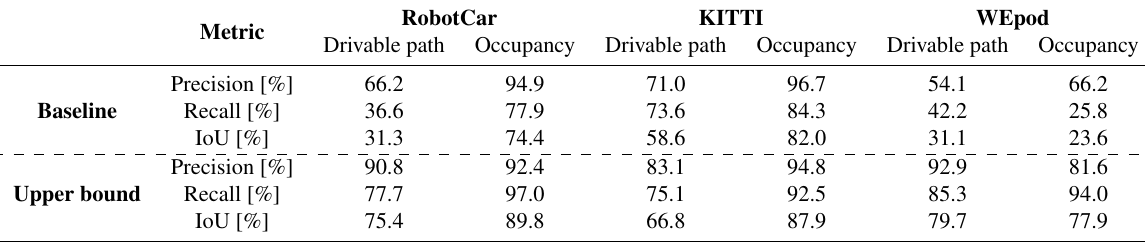
Table 1: Evaluation values for the baseline and upper bound of the experiments.